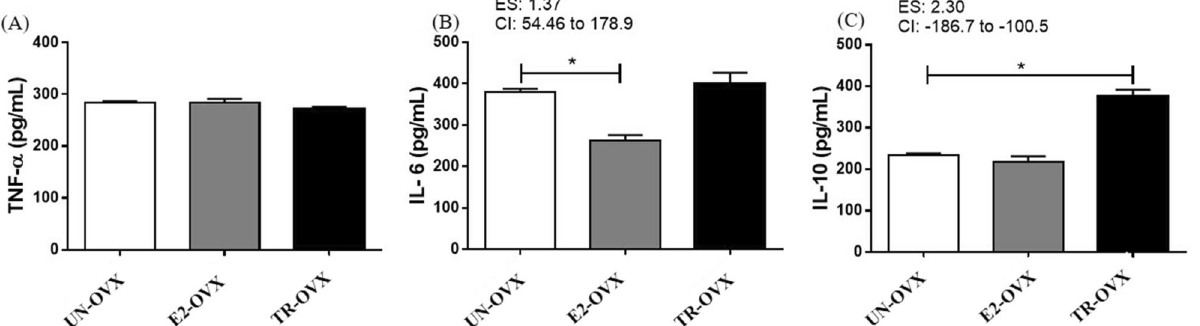
Figure 4. Inflammatory biomarkers assays in the right soleus muscle of untrained ovariectomized rats (UN-OVX), ovariectomized rats treated with Estradiol replacement (E2-OVX), and trained ovariectomized rats (TR-OVX). ( A ). Tumour necrosis factor-alpha (TNF-α). ( B ). Interleukin 6 (IL-6). ( C ). Interleukin 10 (IL-10). N = 10 per group. Data are reported as mean ± S.E.M. 95% confidence interval (CI). Effect size (ES) * p < 0.01. One-way